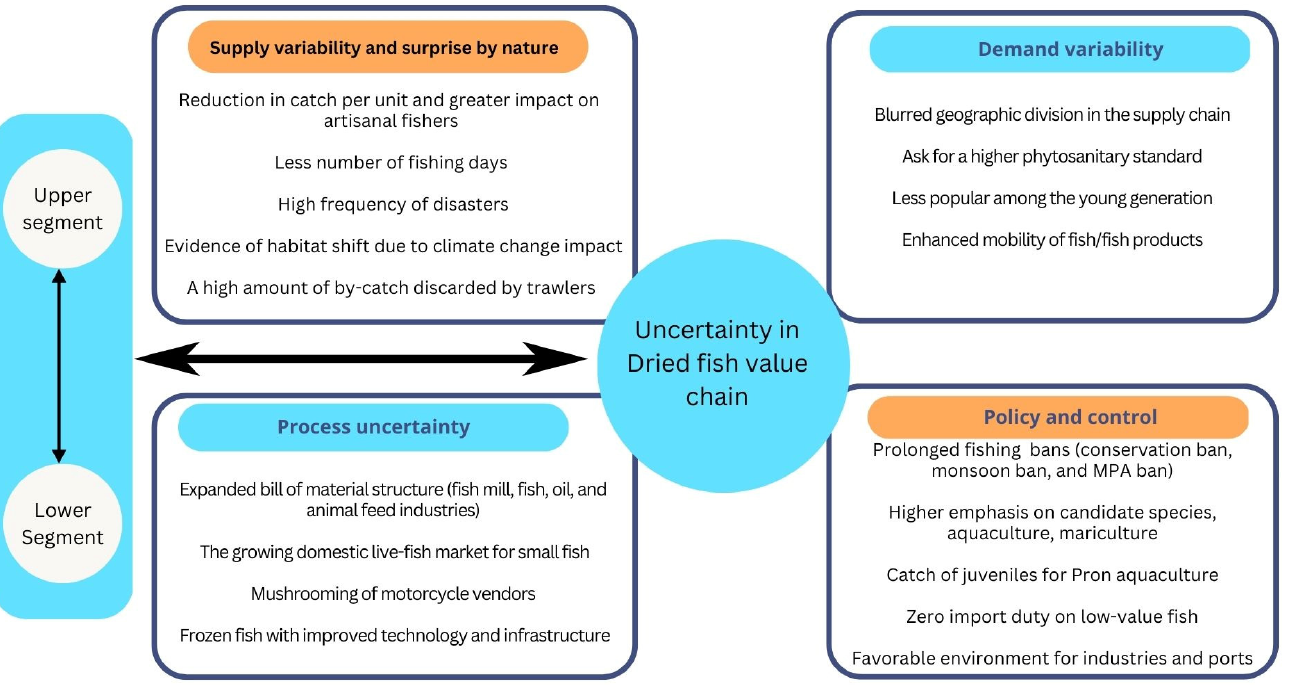
Figure 7. Matrix of key characteristics of uncertainties in the study location.